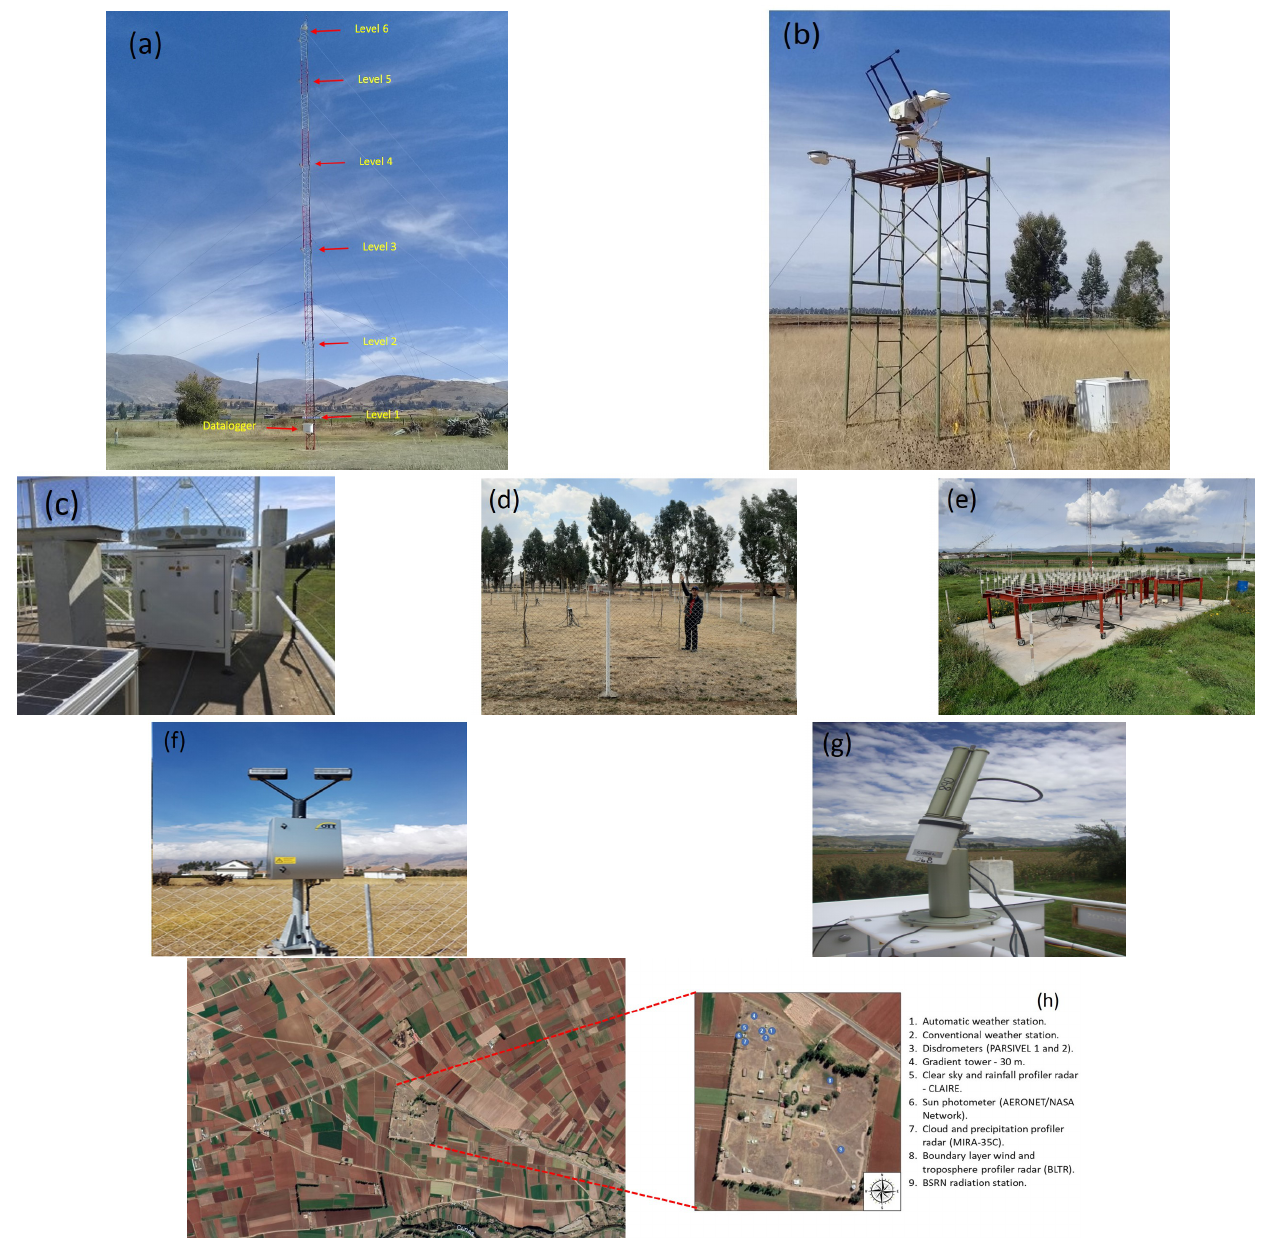
Figure 2. ( a ) Gradient tower located in the HYO with meteorlogical sensors installed at six height levels of 2, 6, 12, 18, 24 and 29 m; ( b ) tower located in the HYO with radiation sensors installed at 6 m high; ( c ) magnetron-based pulsed Ka-Band Doppler radar MIRA-35c; ( d ) boundary Layer and Troposphere Radar (BLTR). Both instruments are installed in the HYO since 2015; ( e ) Clear-Air and Rainfall Estimation (CLAIRE) radar; ( f ) optical disdrometer PARSIVEL. ( g ) Sun Sky Lunar Multispectral Photometer model CE318-T; ( h ) area of study and location of the instruments inside the